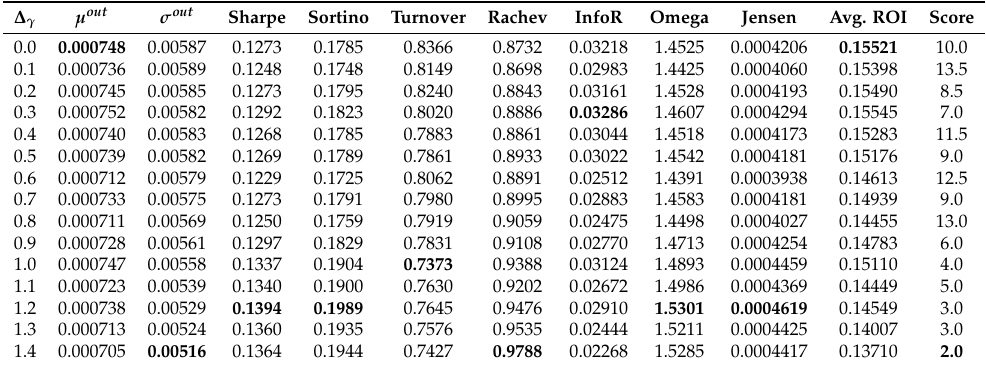
Table 6. EuroBonds: out-of-sample performance results for the RMZ R strategy by varying ∆ γ , where ∆ γ is the skewness parameter and score is the median value of the overall performance rankings. The best results are marked in bold.